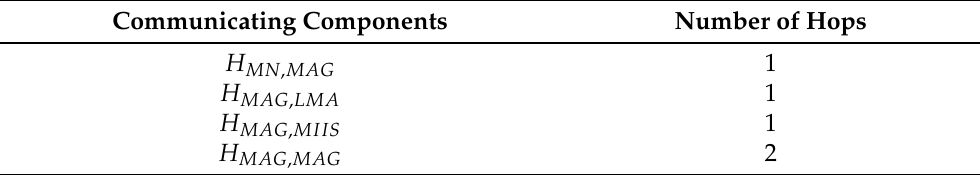
Table 6. The hops between the components of the considered